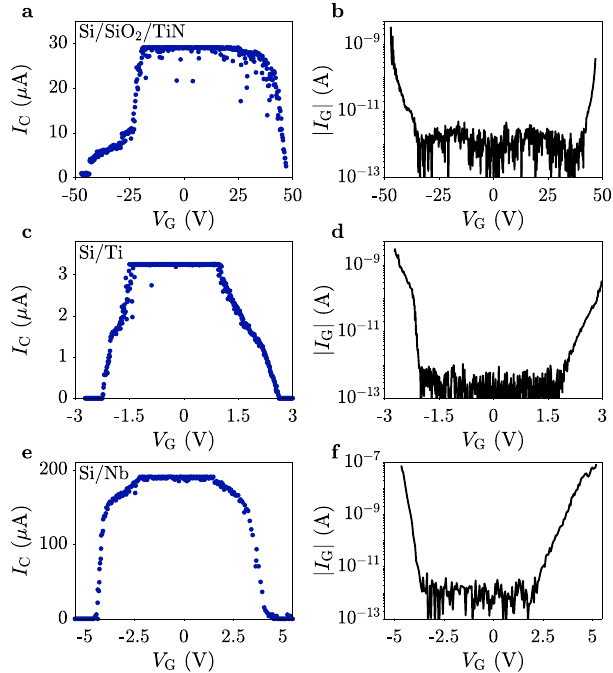
Fig. 3 Critical current suppression in various superconductors. a , b Critical current I C and gate current I G as a function of gate voltage V G for a TiN wire on a 25 nm thick SiO 2 fi lm thermally grown on Si substrate. The wire is 2 μ m long, 80 nm wide, and 20 nm thick. c , d Critical current I C and gate current I G as a function of gate voltage V G for a Ti wire on Si substrate. The wire is 2 μ m long, 200 nm wide, and 30 nm thick. e , f Critical current I C and gate current I G as a function of gate voltage V G for a Nb wire on Si substrate. The wire is 2 μ m long, 200 nm, wide, and 13 nm thick. decreasing. At V G = ±5.5 V, where I G ≈ ±1.5 nA, I C vanished and the nanowire reached its normal state resistance R N = 1.6 k Ω . The parametric plot of I C vs. I G shown in Fig. 1e indicates an extre- mely sharp suppression of I C for small values of I G (~50% of the suppression took place within the noise level for I G ), followed by a slower decay which persisted up to I G ~ 1.5 nA.